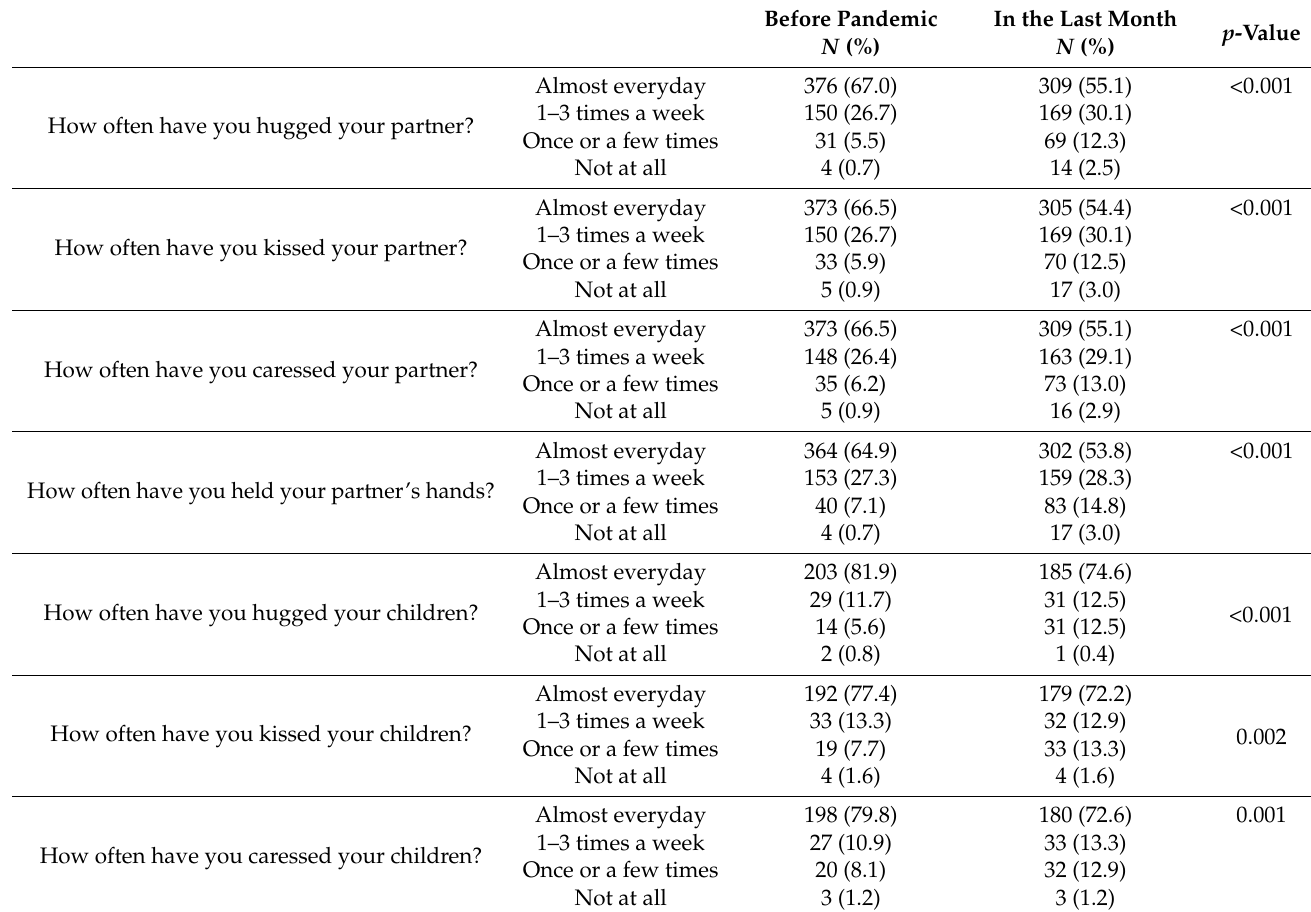
Table 1. Frequency of reporting physical positive touch before pandemic and in the last month with cohabiting people.